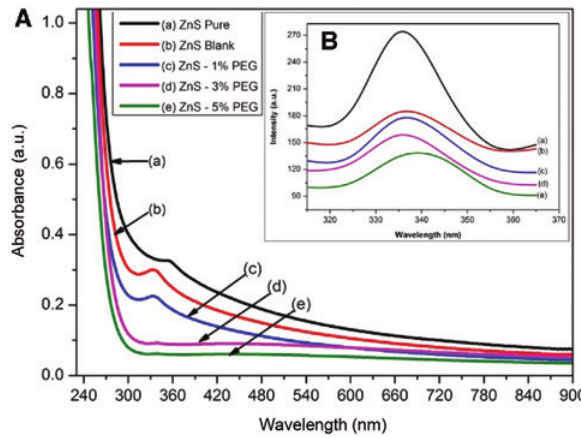
uncapped (a) blank and (b) ZnS nanoparticles capped with (c) 1%, (d) 3%, and (e) 5% PEG.